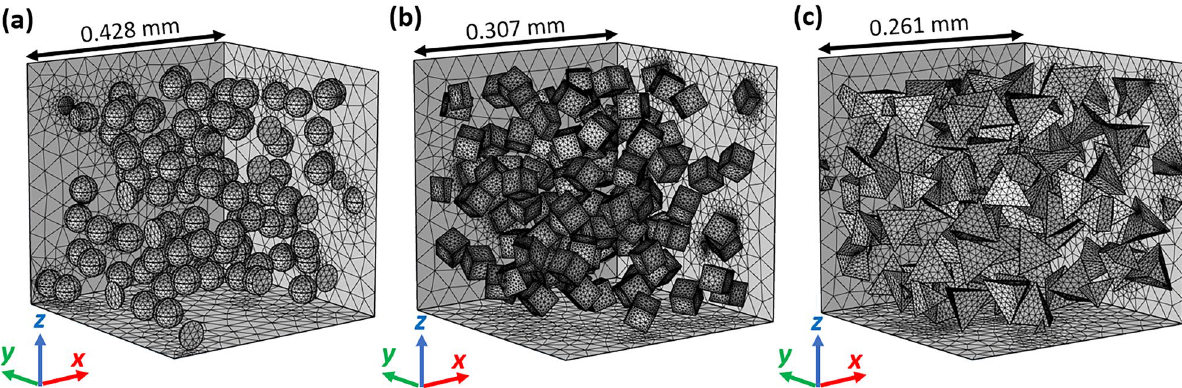
Figure 1. FEM models (with meshes) of the composite with wt = 29.6% as implemented in COMSOL Multiphysics 5.4 29 —representative volume elements containing 100 grains (with diameter of 50 µm) in the shape of: ( a ) spheres, ( b ) cubes, ( c )